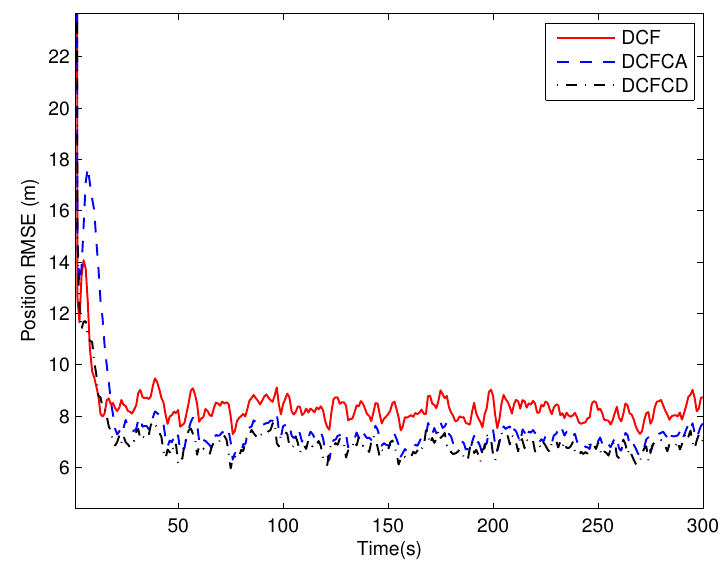
Figure 3. The position RMSE for different methods over time under colored noise.